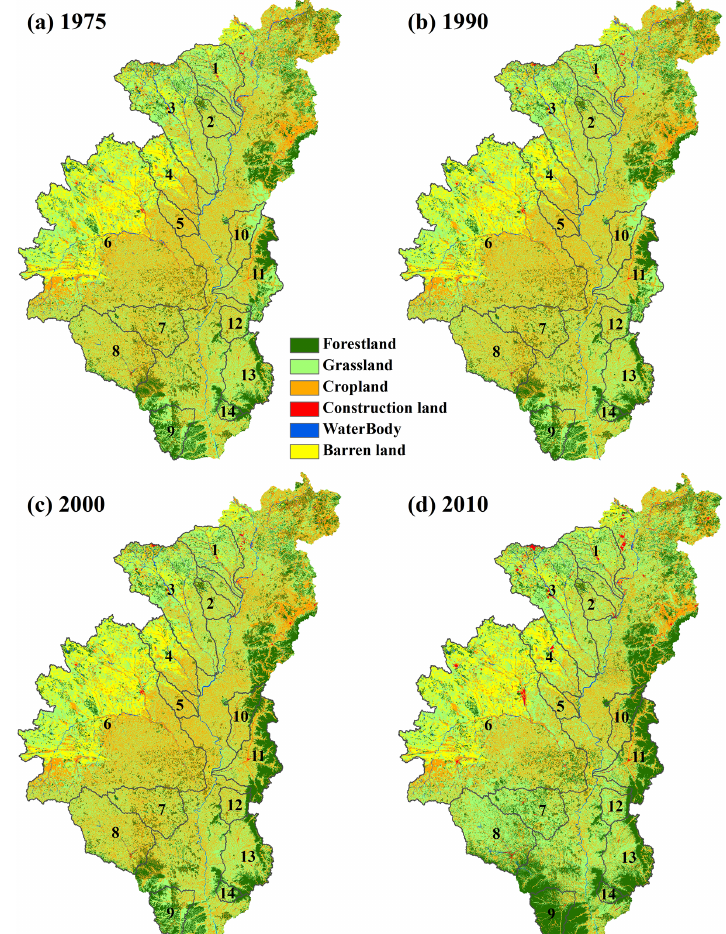
Figure 4. Land use and cover of the study area in (a) 1975, (b) 1990, (c) 2000, and (d) 2010.